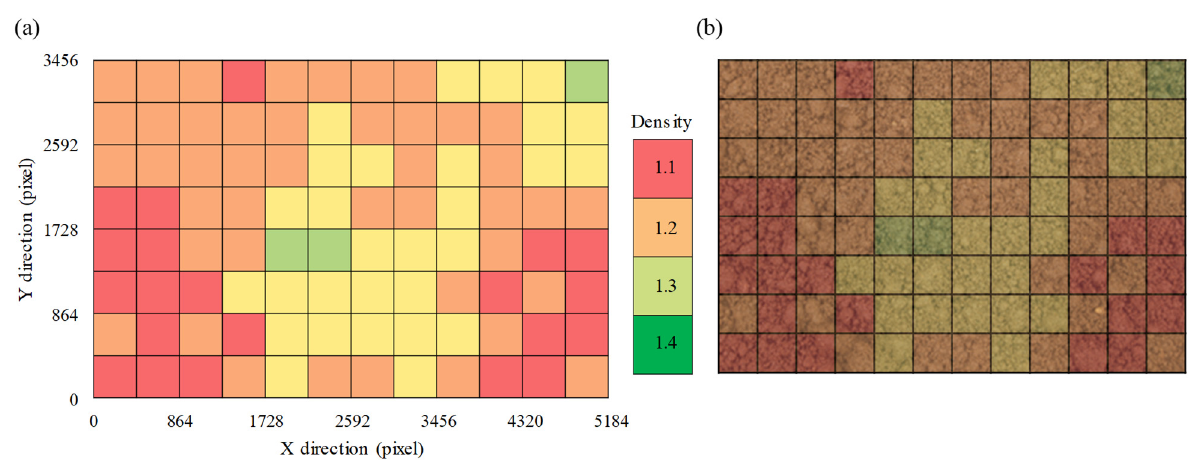
Figure 10. Example of soil water content prediction by the convolutional neural network model. ( a ) Classification result with a resolution of 216 × 216 segmented images.; ( b ) original image overlaid with classification result.